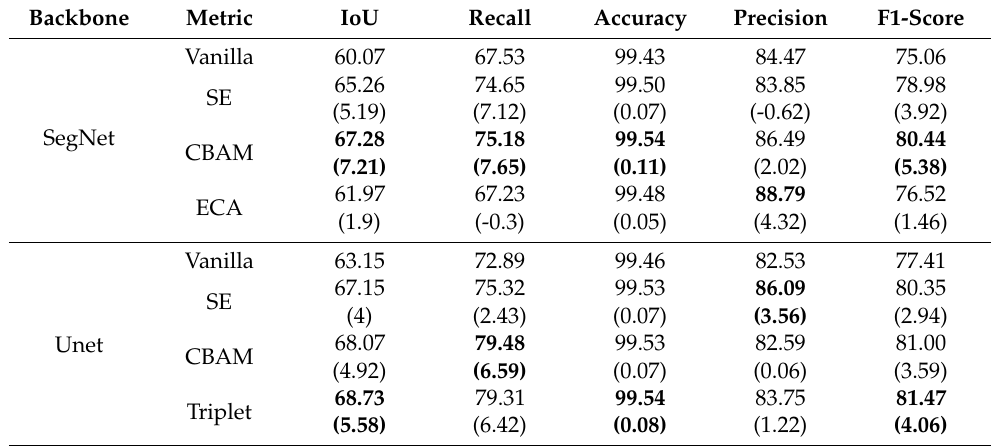
Table 4. Building segmentation with different backbones and AMs on WHU building segmentation dataset. The best record and improvement in each metric are marked in bold. The numbers in the brackets are the difference between the results of attention-based network and vanilla